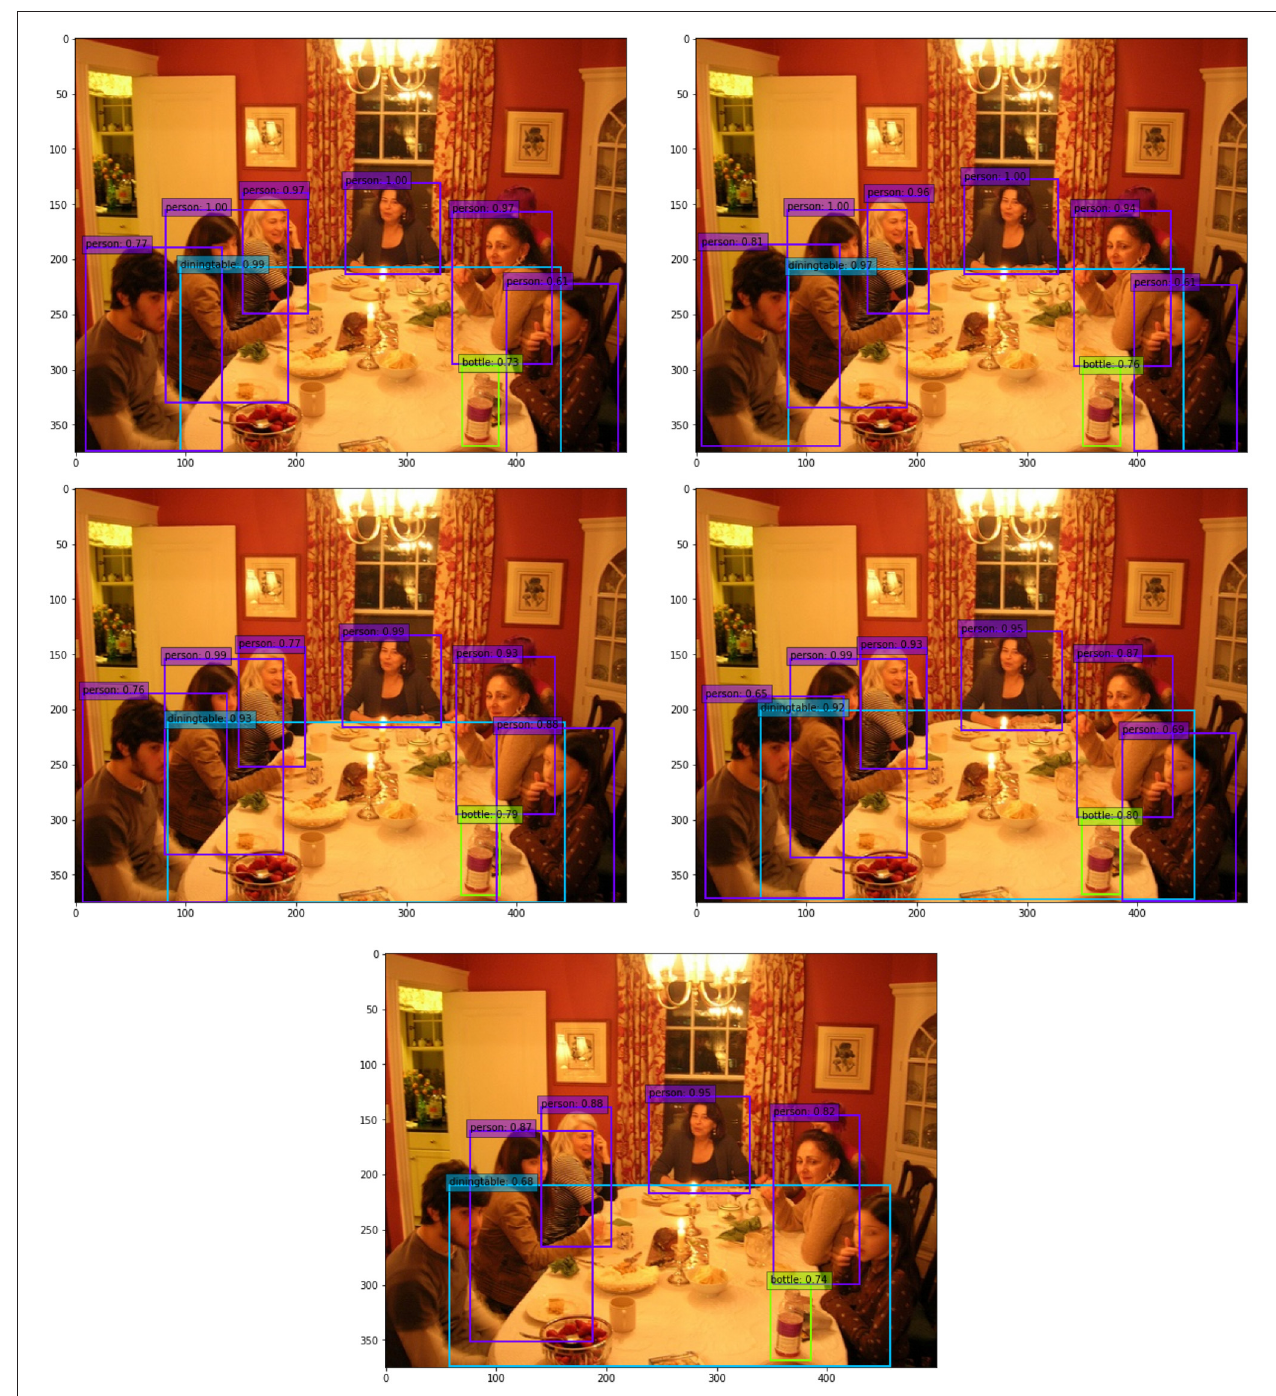
FIGURE 2 | Example of the elasticized single-shot multibox detector network output after 30 % pruning. Top-left − ESSD 5 , Top-right − ESSD 4 , Mid-left − ESSD 3 , Mid-right − ESSD 2 , Bottom − ESSD 1